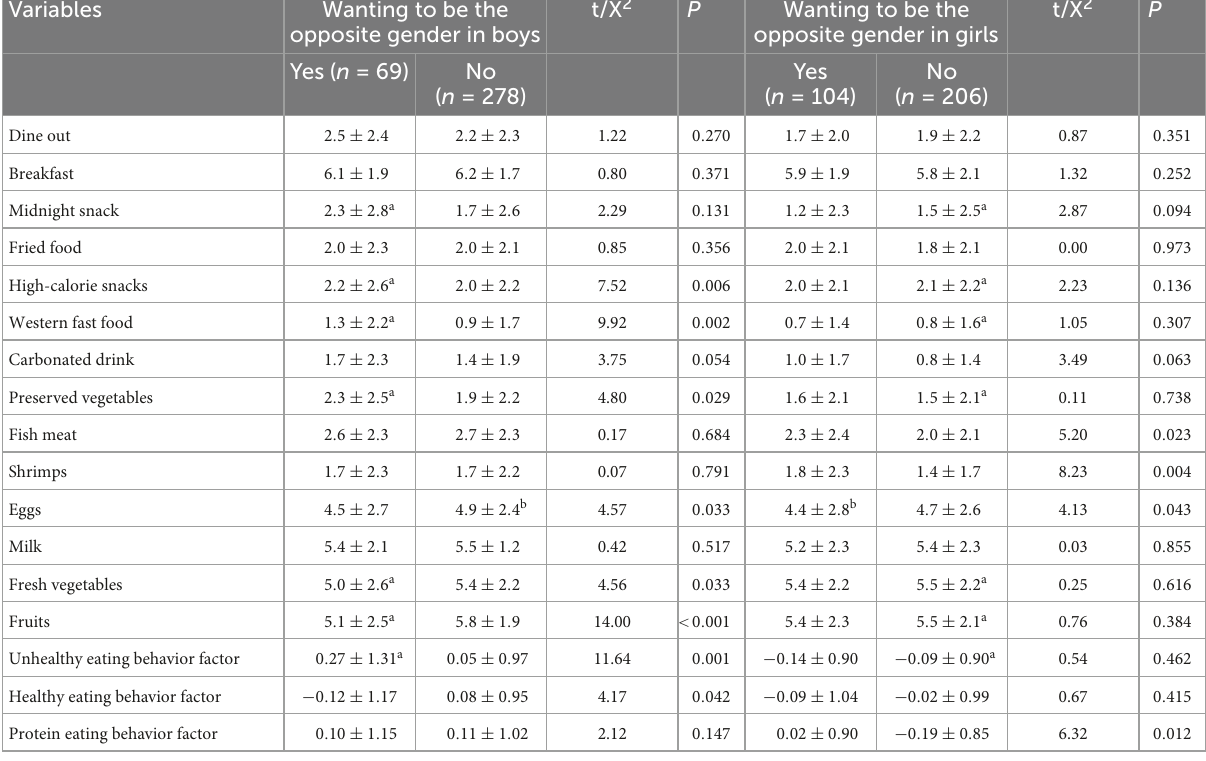
TABLE 5 Comparisons of differences in eating behaviors between children and adolescents with wanting to be opposite gender and no wanting to be opposite gender. Variables Wanting to be the t/X 2 P Wanting to be the t/X 2 opposite gender in boys opposite gender in girls